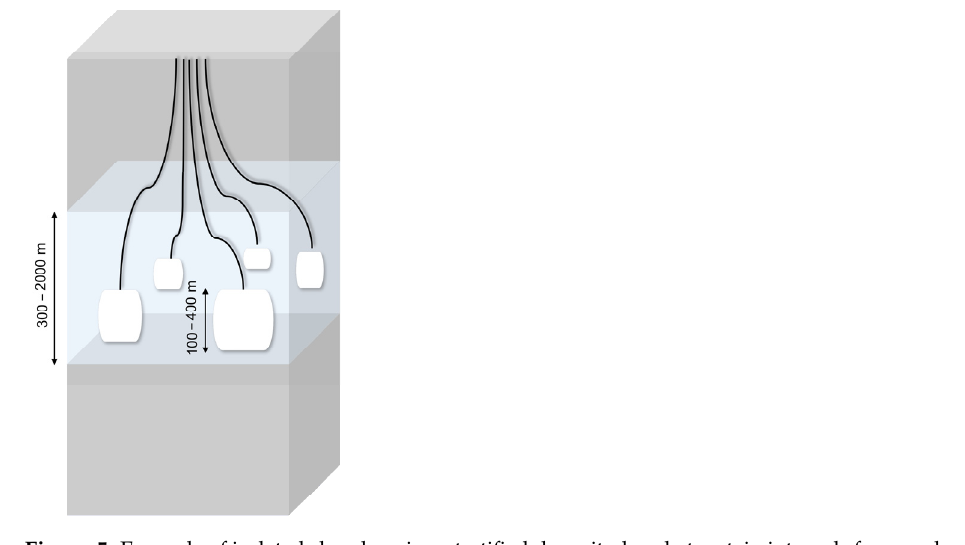
Figure 5. Example of isolated chambers in a stratified deposit placed at certain intervals from each